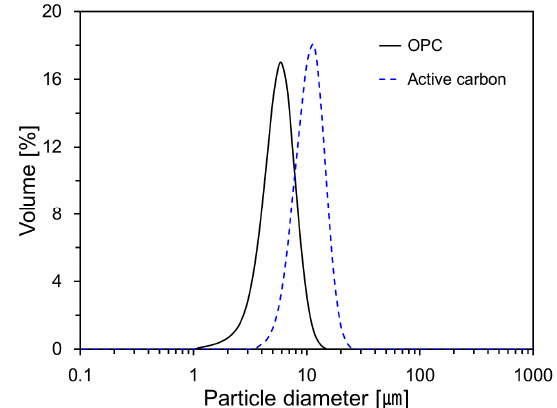
Figure 2. Particle size distributions of activated carbon and OPC.